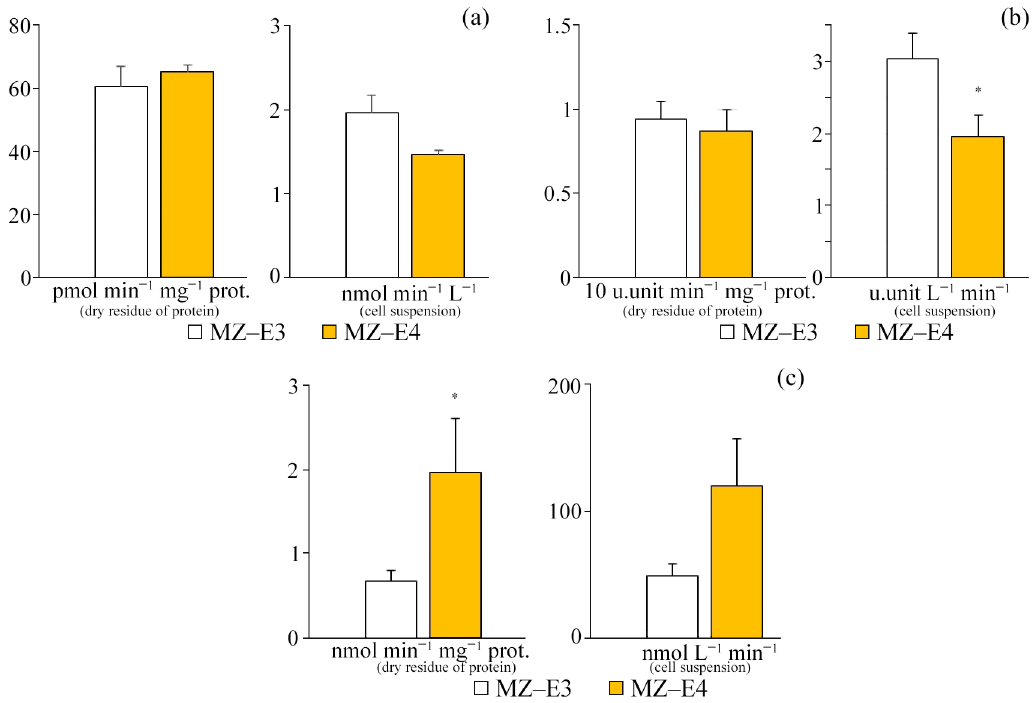
Figure 4. Antioxidant enzyme activity on the dry residue of protein and cell suspension of Vischeria vischeri strains (MZ–E3; MZ–E4). ( a ) CAT activity. ( b ) SOD activity. ( c ) GPO activity. Medium: BBM; culture volume: 250 mL; incubation time: 25 days; M ± S.E., n = 3; * the differences are significant relative to MZ–E3 ( p ≤ 0.05).